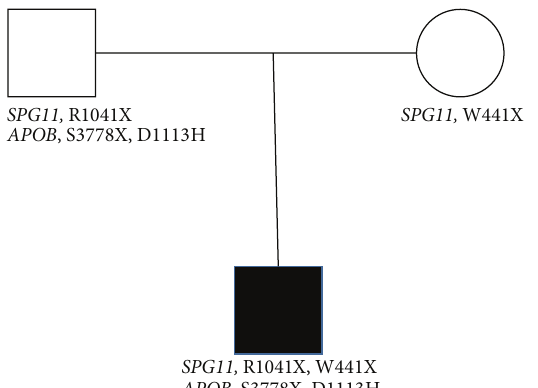
Figure3:Pedigreeofthefamilyshowingtheparentsandtheaffected individual with mutations in the SPG11 and APOB gene. The son is compoundheterozygousfor SPG11 mutations,inheritingonevariant from each of the parents. Both APOB variants were inherited from the